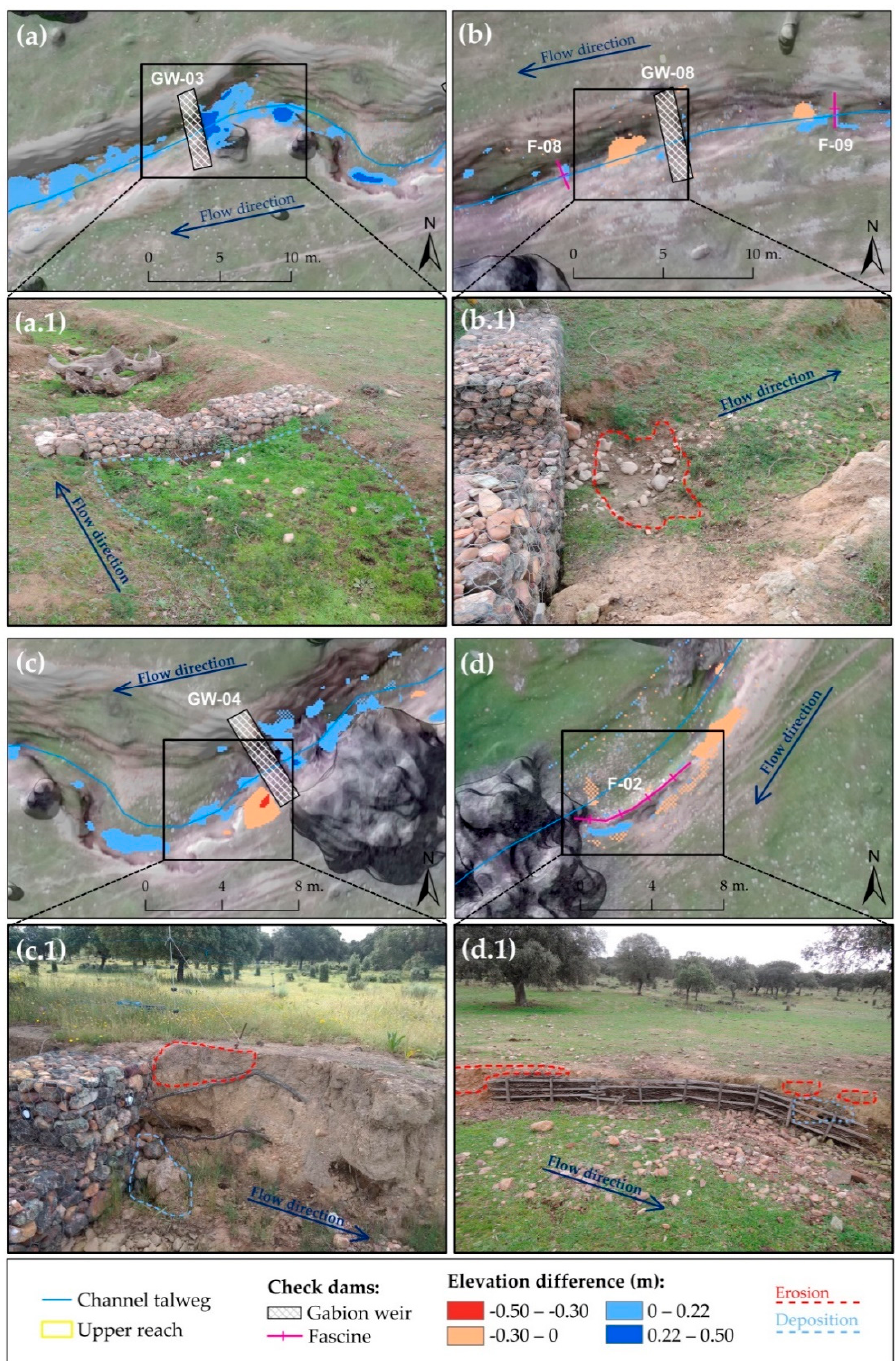
Figure 10. Detailed examples of processes observed close to some check dams through digital elevation model of differences (DoD) from February 2017 to January 2019 and photographs: ( a , a.1 ) sediment deposition behind GW-03 and the corresponding photograph; ( b , b.1 ) channel in- cision just downstream of GW-08 and the corresponding photograph; ( c , c.1 ) lateral bank erosion downstream of GW-04 and a view of the area; ( d , d.1 ) reduction of lateral bank erosion as result of the implementation of F-02 and the photograph of this geomorphological process. GW = gabion weir and F =